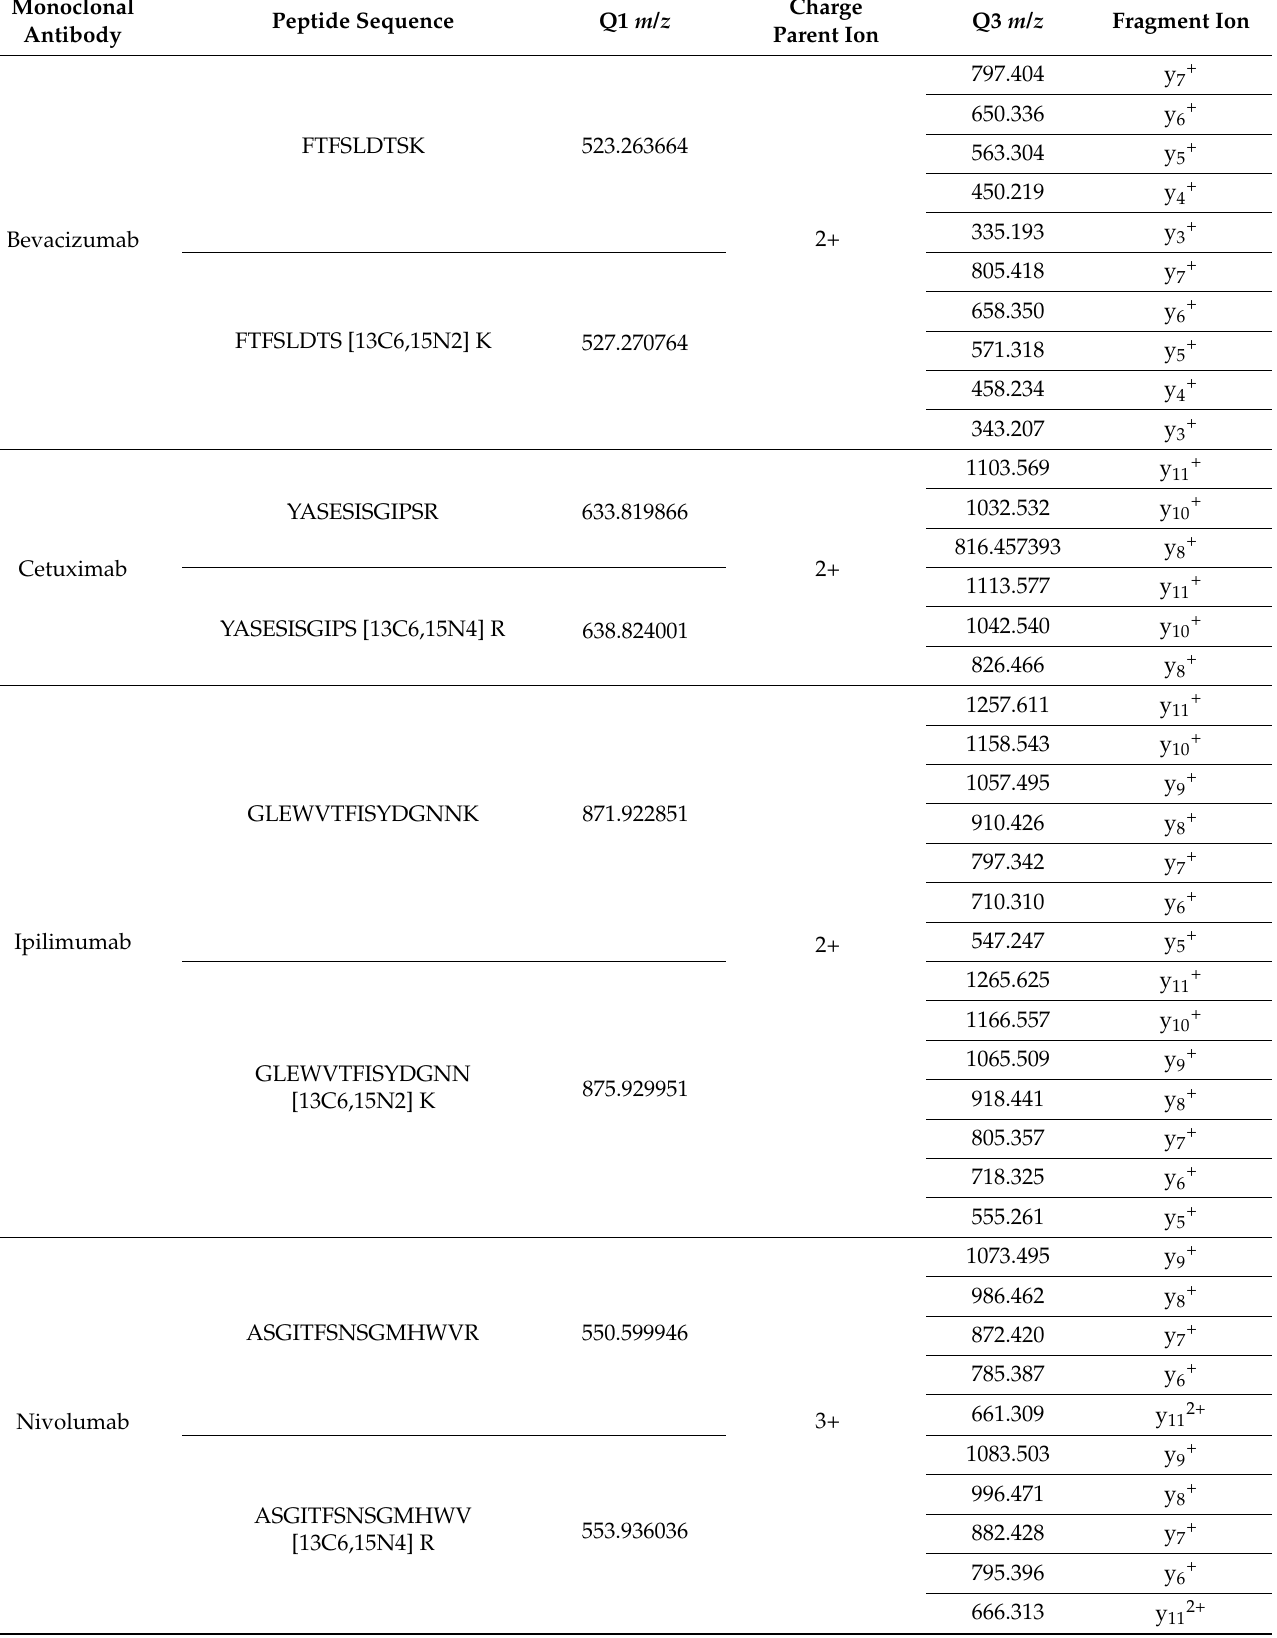
Table 3. Surrogate peptides used for OTDM1 monoclonal antibodies quantification in plasma and their corresponding MRM transitions. All peptide listed were used as